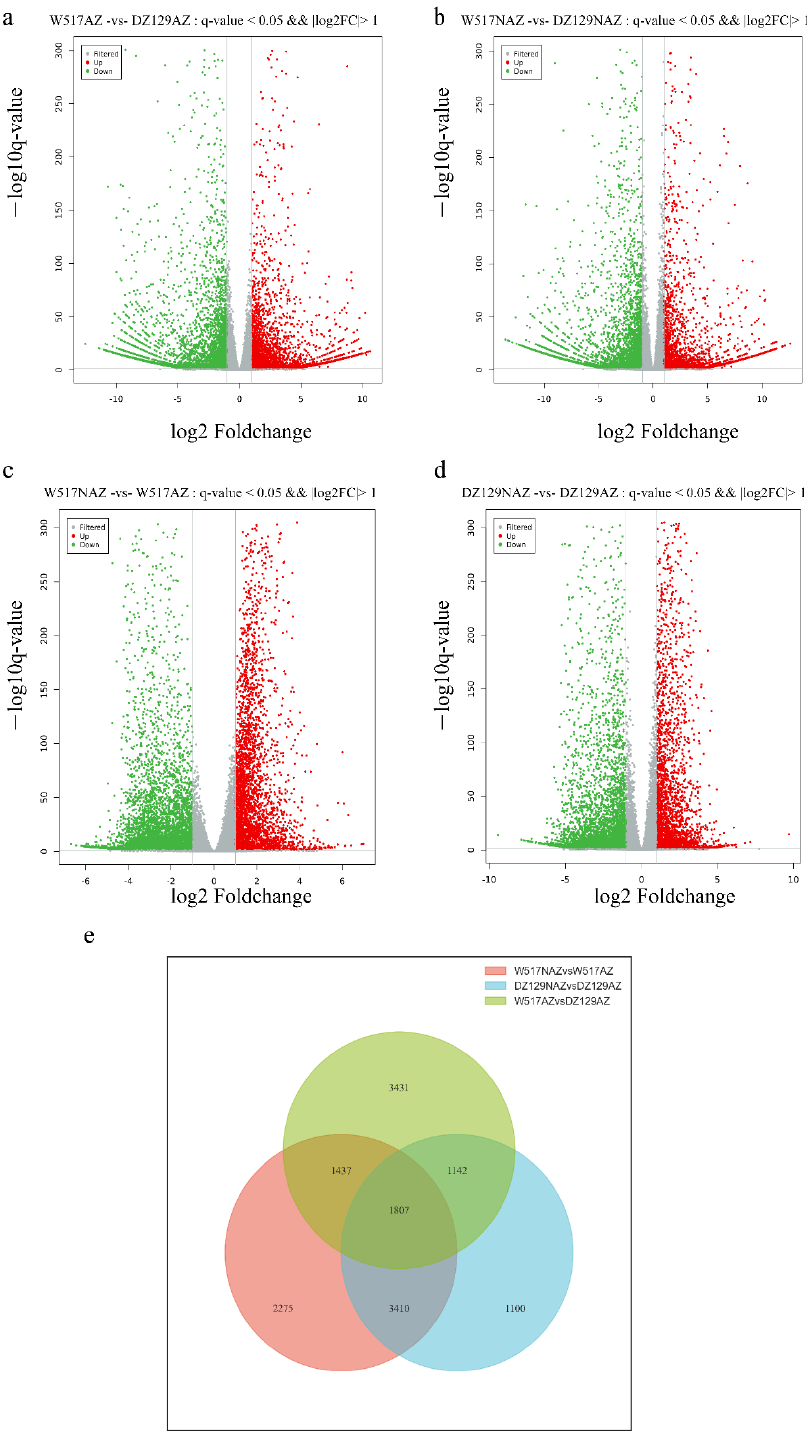
Figure 4. RNA-seq analysis between the AZ and NAZ of extreme materials: ( a ) Volcano plot displaying DEGs between the extreme materials at the AZ (W517AZ vs. DZ129AZ). ( b ) Volcano plot displaying DEGs between the extreme materials at the NAZ (W517NAZ vs. DZ129NAZ). ( c ) Volcano plot displaying DEGs between the AN and NAZ of W517 (W517NAZ vs. W517AZ). ( d ) Volcano plot displaying DEGs between the AZ and NAZ of DZ129 (DZ129NAZ vs. DZ129AZ). ( e ) Venn diagram analysis of the third set of DEGs.